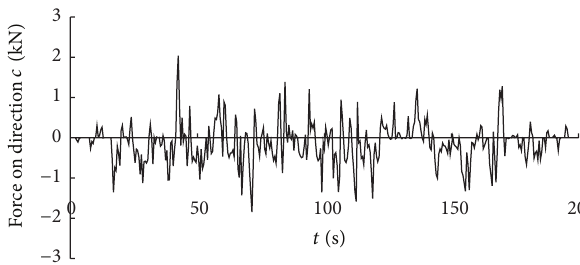
Figure 13: Time history curve of the force on direction 𝑐 on cutting head.